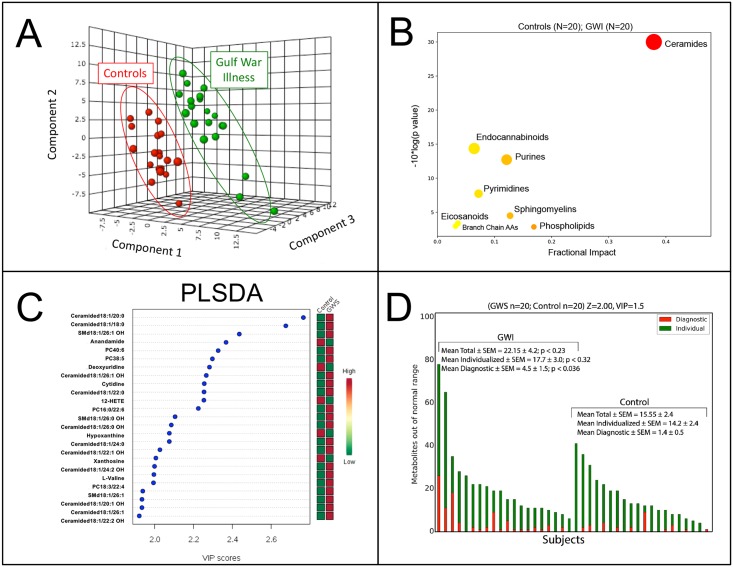
Metabolite and biochemical pathway abnormalities in Gulf War illness.A. Multivariate metabolomic discrimination of GWI from controls. (n = 20 males with GWI; 20 male controls). PLSDA: partial least squares discriminant analysis. B. Pathway bubble plot indicating the fractional metabolic impact. C. Rank order of the top 25 discriminating metabolites by multivariate variable importance in projection (VIP) scores. D. Individual vs Diagnostic Metabolite Abnormalities. Diagnostic metabolites (blue) were defined as having VIP scores of ≥ 1.5 and a Z-score of ≥ 2.0 or ≤ -2.0 in the same direction, above or below the control mean, as found by multivariate PLSDA. Individualized abnormalities (yellow) met the Z-score criterion but were not significant by VIP score and were not diagnostic for GWI.